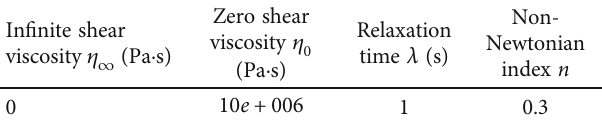
Table 2: Physical parameters of rubber compound.